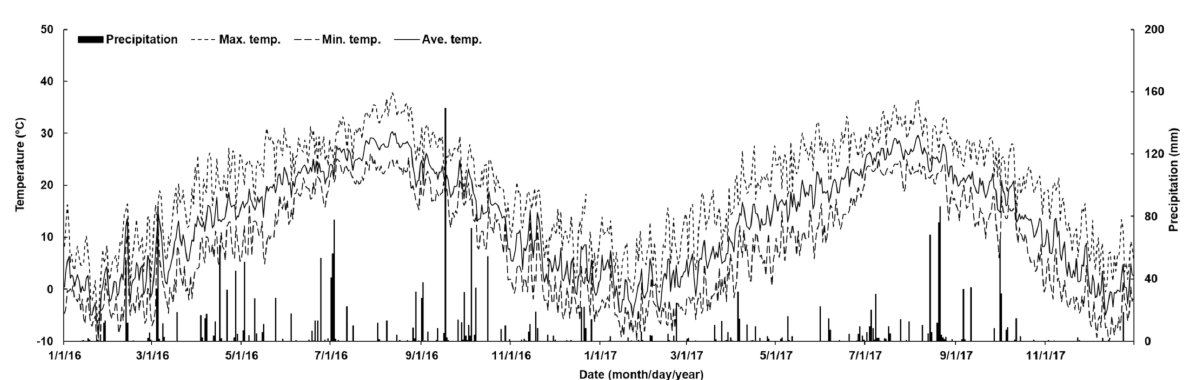
Figure 2. Mean daily precipitation and air temperature during rice